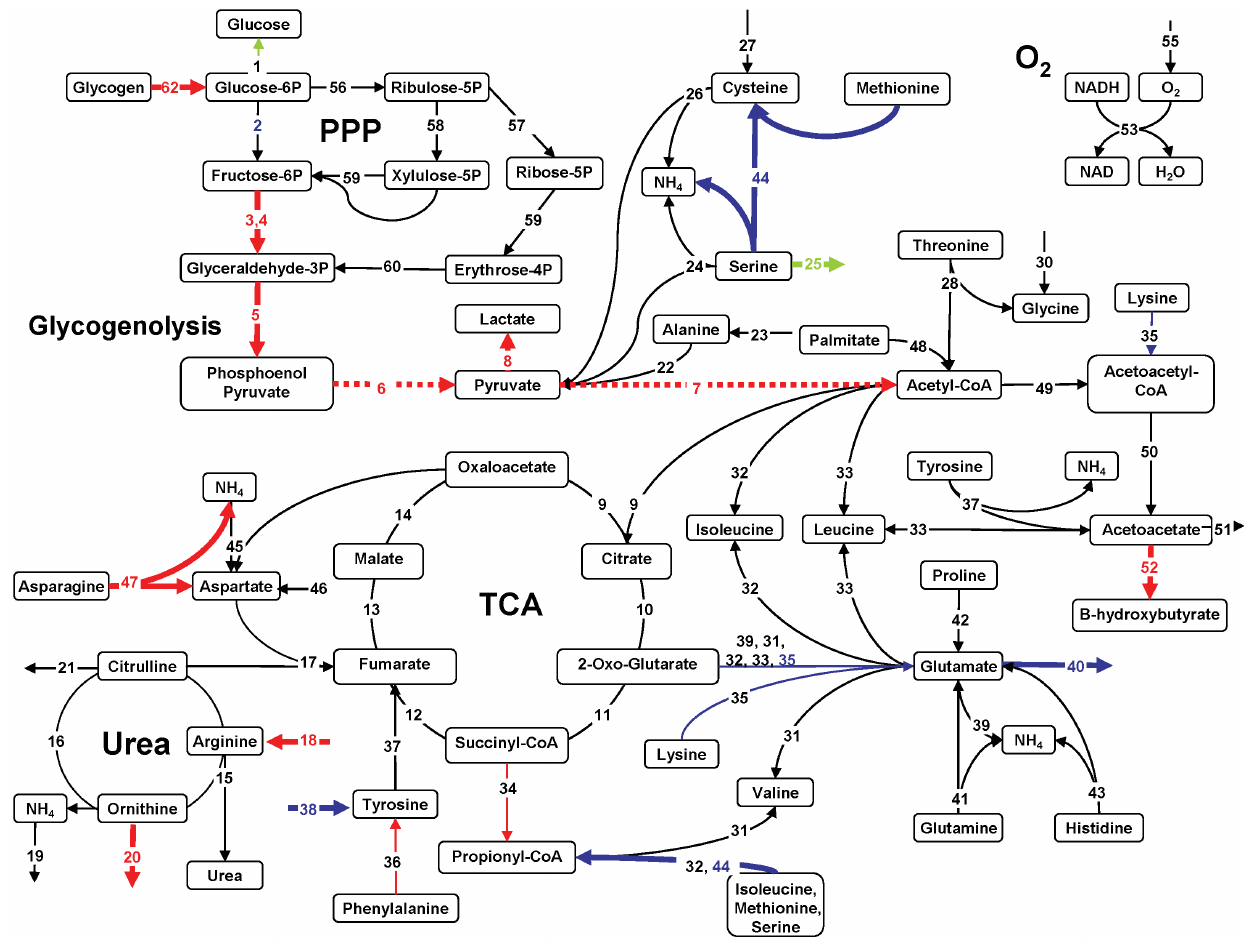
Figure 4. MFA of phase I (t=0–2 hrs) for WI livers compared to Fresh livers; Fresh liver MFA forms the black baseline. Red arrows are significantly increased fluxes. Blue arrows are significantly reduced fluxes and green are reversed. Bold lines=p , 0.05, Thin lines=p , 0.1, Dotted lines=glycolysis.